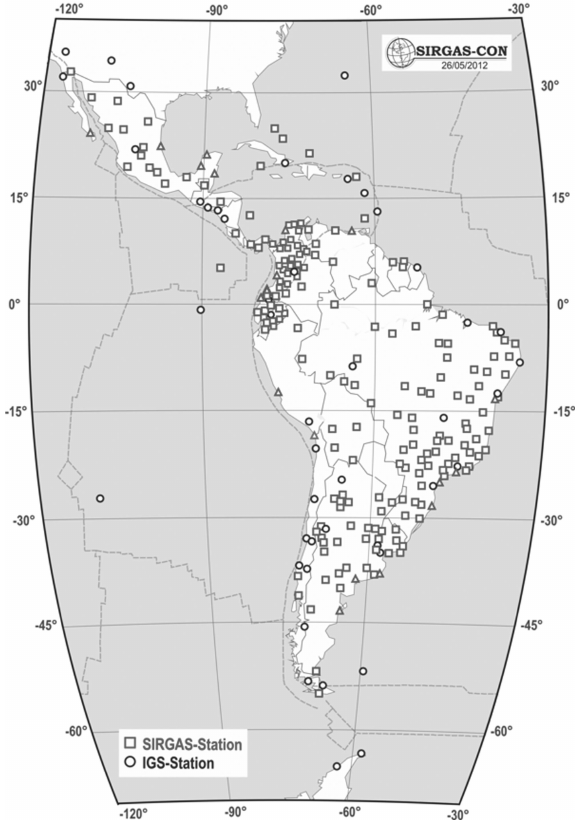
Figure 1. SIRGAS-CON network (modifed from: www.sirgas.org accessed on 20/03/2012).